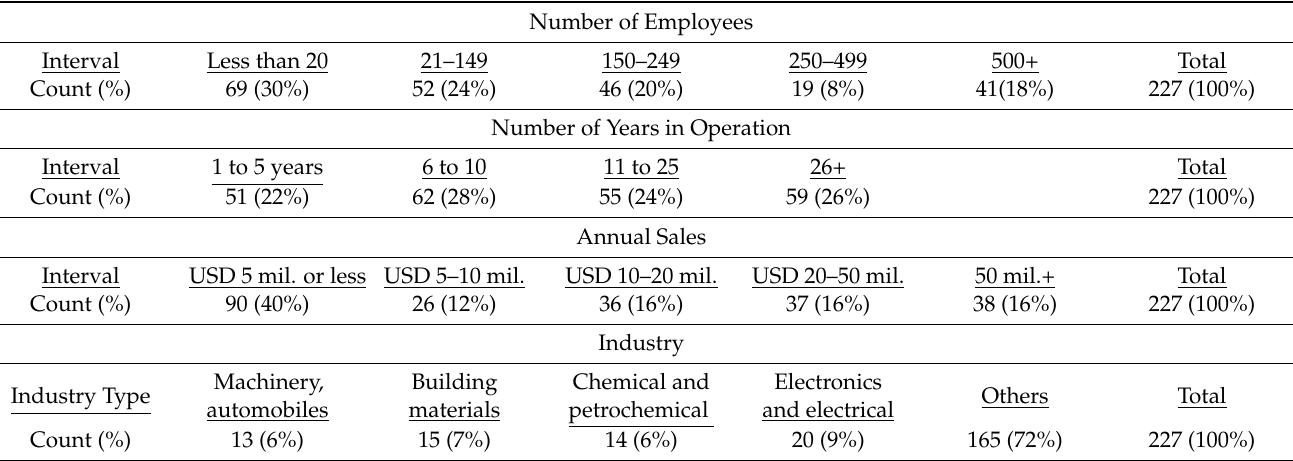
Table 1. Demographics of the Sample.